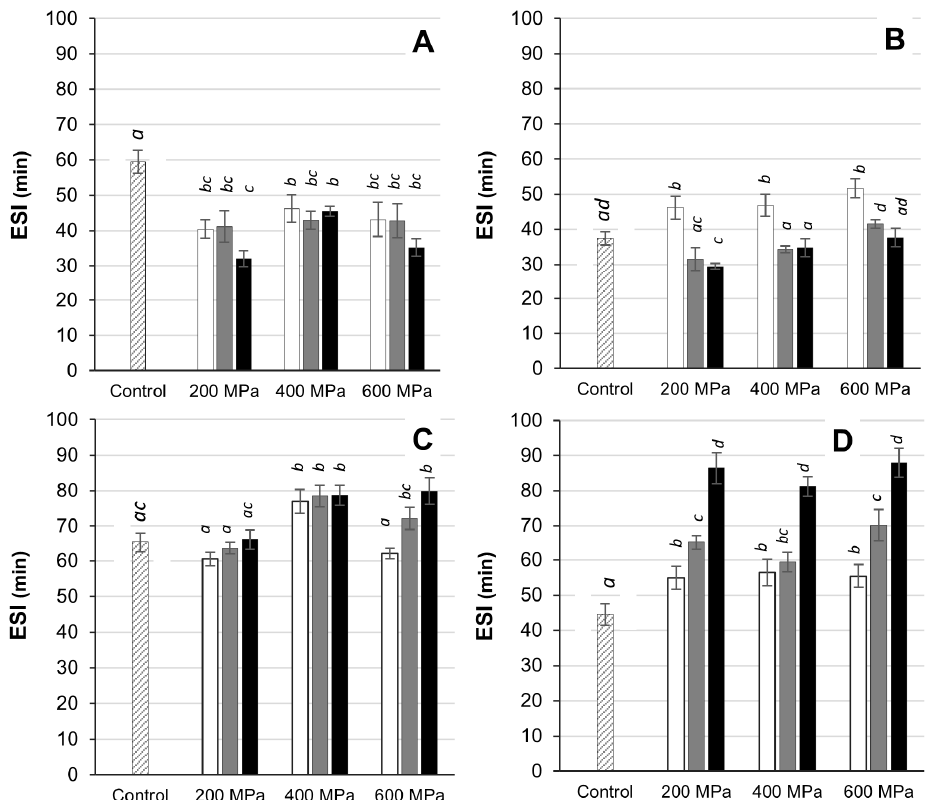
Figure 6. Emulsifying stability index (ESI) measured for O/W emulsions prepared with soy protein dispersions previously subjected to different high-pressure processing treatments (200, 400 and 600 MPa). The columns with diagonal stripes represent control samples (0.1 MPa); blank, gray and black filled columns denote 5-, 10- and 15-min processing times, respectively. Selected data shown correspond to ( A )—total soy protein at pH 6; ( B )—soluble soy protein at pH 6; ( C )—total soy protein at pH 8; and ( D )—soluble soy protein at pH 8. Different letters indicate significant differences ( p < 0.05) between samples represented in each figure; vertical bars denote the standard deviation from three replicates.